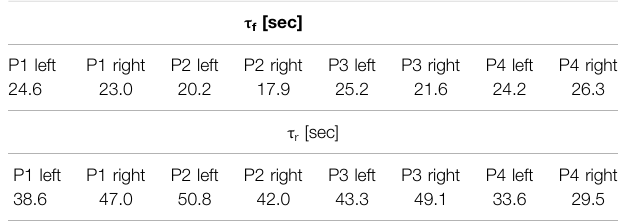
TABLE 3 | Main control parameters that were used during the experiments for all